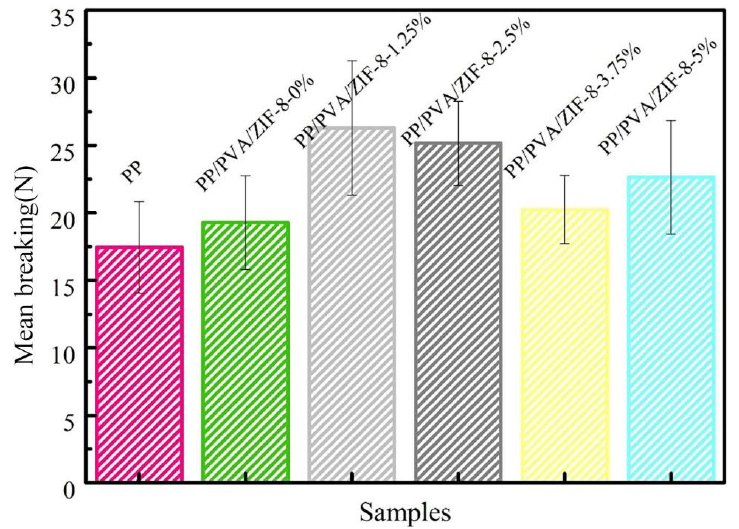
Figure 12. Mean breaking strength of PP melt-blown membranes and PP/PVA/ZIF-8 melt-blown electrospun composite membranes.